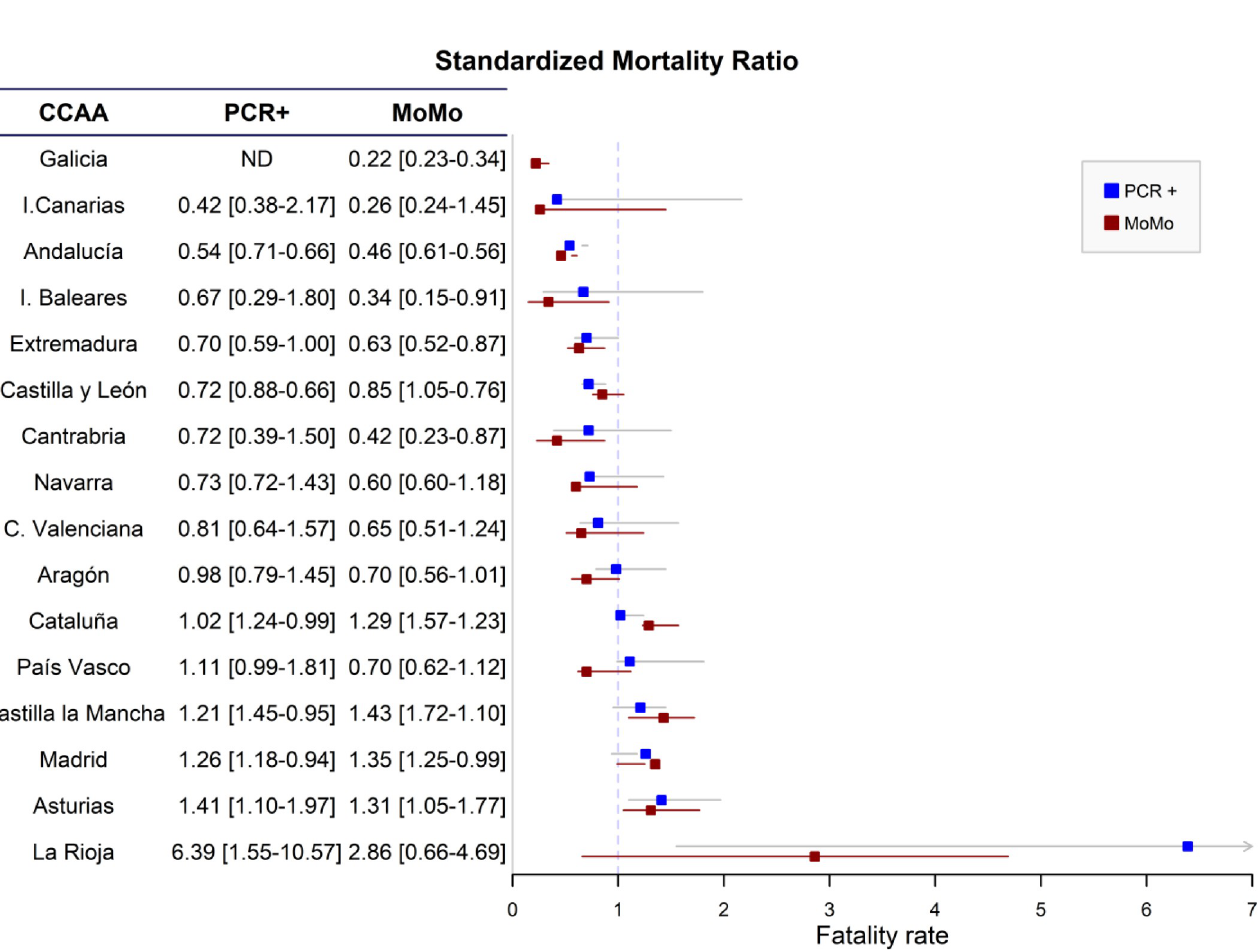
Fig 3. Distribution of the standardized case fatality ratio (SCFR) and ranges according to prevalence of infection calculated from de ENE-COVID-19 study and adjusted for age group in the different Autonomous Communities (CC.AA).